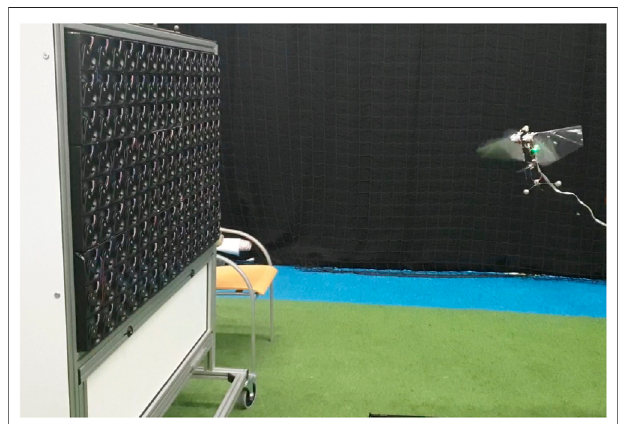
FIGURE 7 | The test setup of free fl ight experiments of the asymmetric fl apping-wing MAV with the low-speed multi-fan wind system.